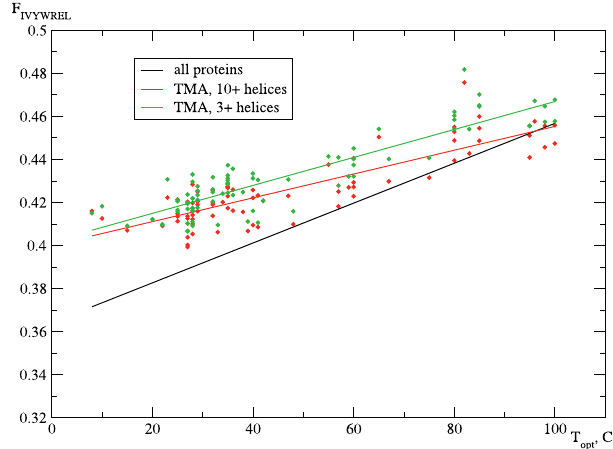
Figure 4. Total Fraction of IVYWREL Amino Acids in Alpha-Helical Membrane Proteins Containing Three or More (Green) or Ten or More (Red) Helices, Plotted against the OGT Solid lines are linear regressions. The black line is the linear regression of the fraction of IVYWREL amino acids in all proteins in a proteome, the same as in Figure 1. The fraction of IVYWREL in membrane proteins of thermophilic organisms is about the same as in all of their proteins. In mesophiles, membrane proteins are enriched with hydrophobic residues. For membrane proteins with ten or more helices, the five best predictors are ILVWYGERKP, FILVWYATSERKP, FILVWYATSEHRKP, IVYWREL, MFILV- WYATSEHRKP, 0.85 , R ,